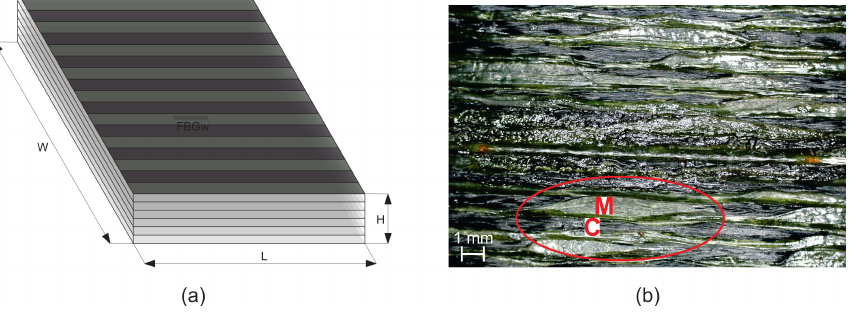
Figure 2. Sample: ( a ) Scheme with FBG sensor locations, ( b ) surface photograph; C—carbon fibre bundle, M—polymeric matrix.